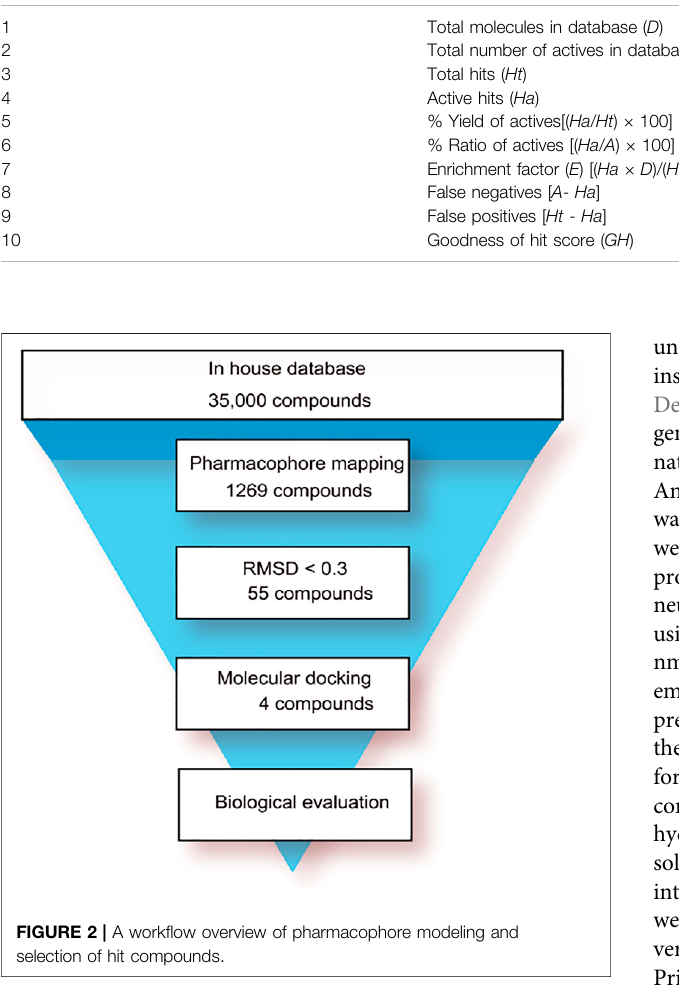
TABLE 1 | Pharmacophore model validation using GH score method. Serial no.